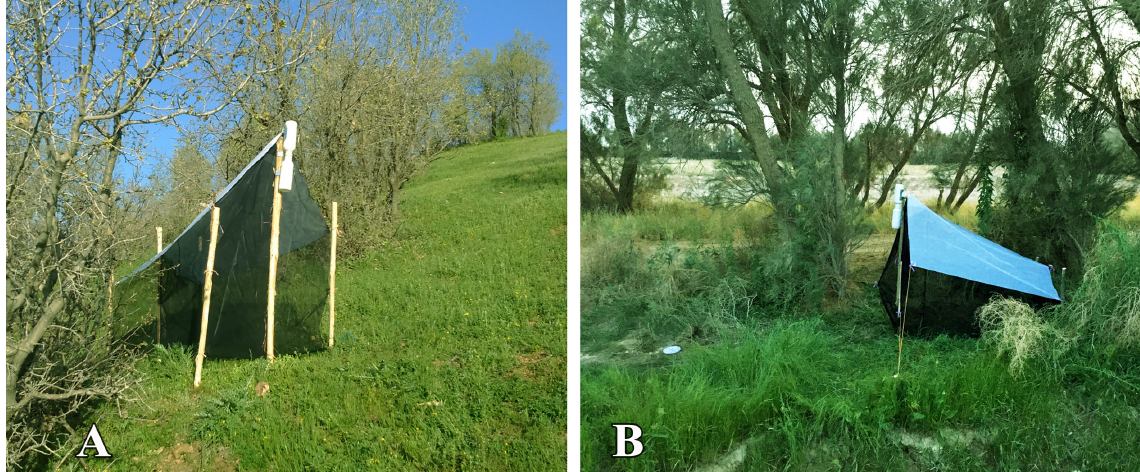
Fig. 1. Malaise traps at collection sites in Iran. A . Kermanshah, Kermanshah Province. B . Zabol, Sistan-o Baluchestan